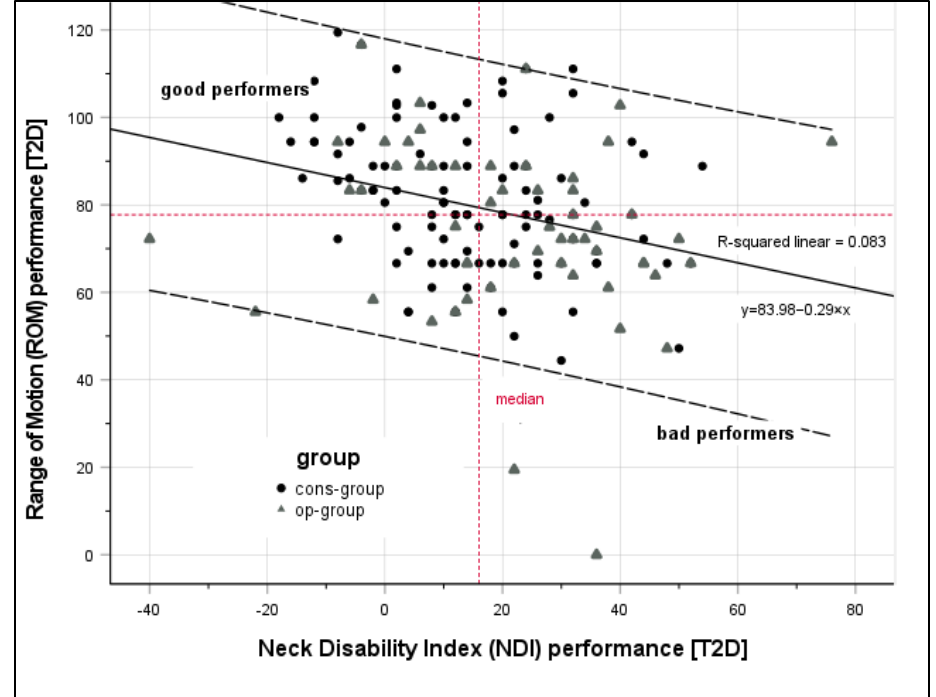
Figure 2. Scatter plot of T2D scores [ T 2 + ( T 2 − T 1)] of Range of Motion (ROM) and Neck Disability Index (NDI).